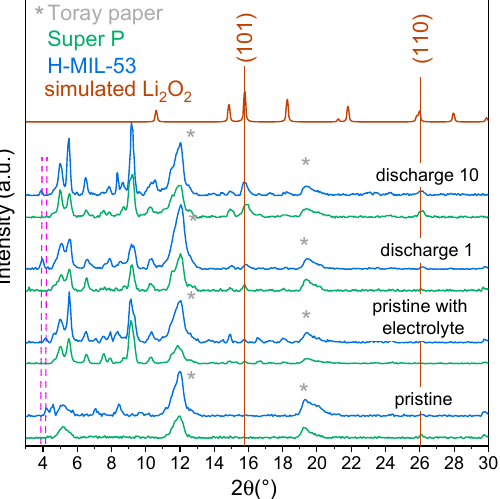
that the Li 2 O 2 thin plates lead to the development of toroid particles and then sphere particles [33]. Assuredly, both SEM and XRD results demonstrate that Li 2 O 2 is the main discharge product formed when the H-MIL-53 electrodes are used as cathodes.